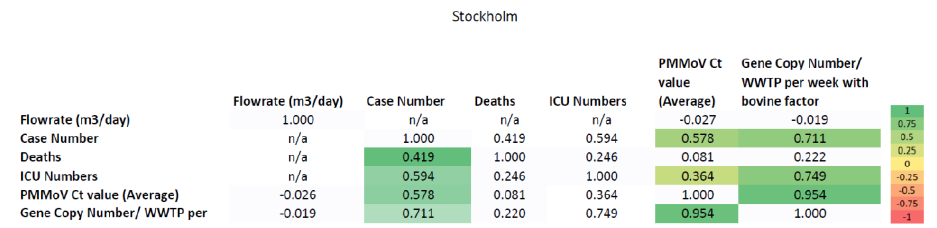
Figure 5. Correlation analysis between PMMoV Ct value and gene copy number/WWTP per week, with the bovine factor, for Stockholm. The positively correlated parameters are highlighted in green (high correlation coefficient) and yellow (low correlation coefficient). The negatively correlated parameters are highlighted in the red boxes (n/a: not